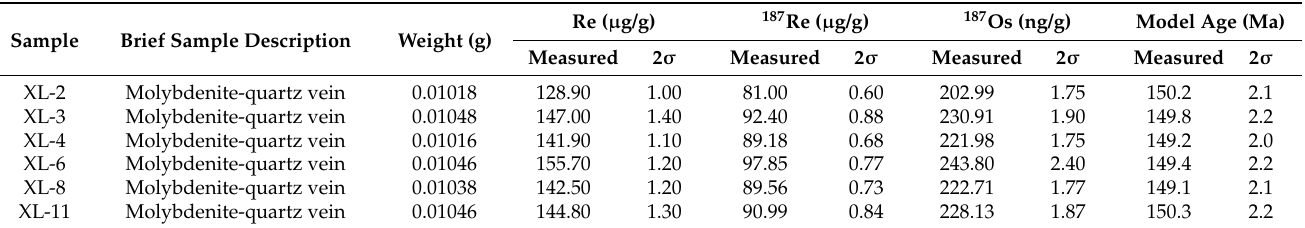
Table 2. Re–Os isotope data for molybdenite samples from the porphyry Mo orebodies from the Xianlin deposit.